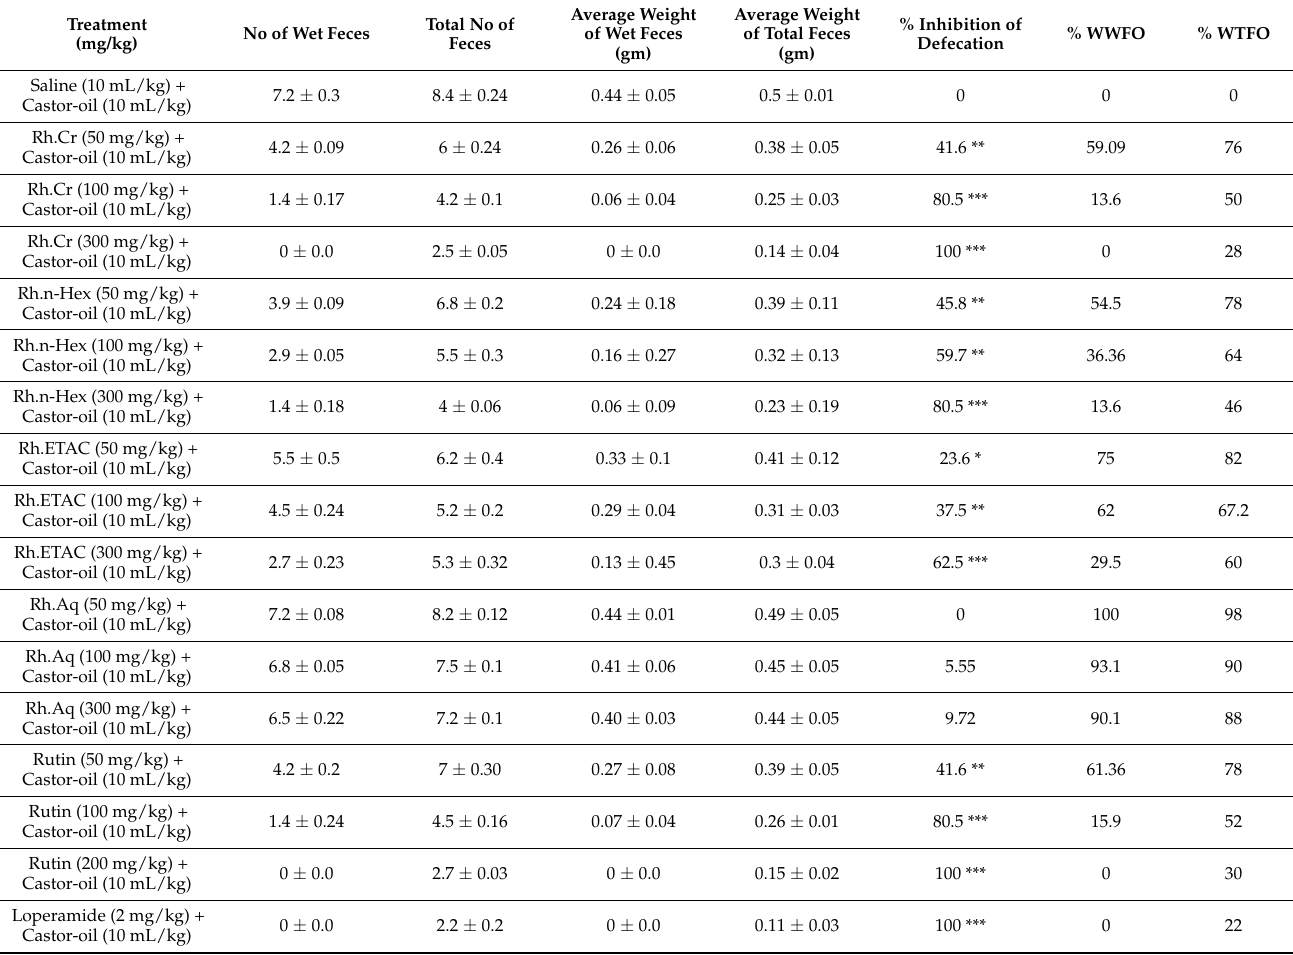
Table 3. Effect of Rumex hastatus crude extract (Rh.Cr) and fractions: n-hexane (Rh.n-Hex), ethyl acetate (Rh.ETAC), aqueous (Rh.Aq), rutin and loperamide against castor-oil induced diarrhea in